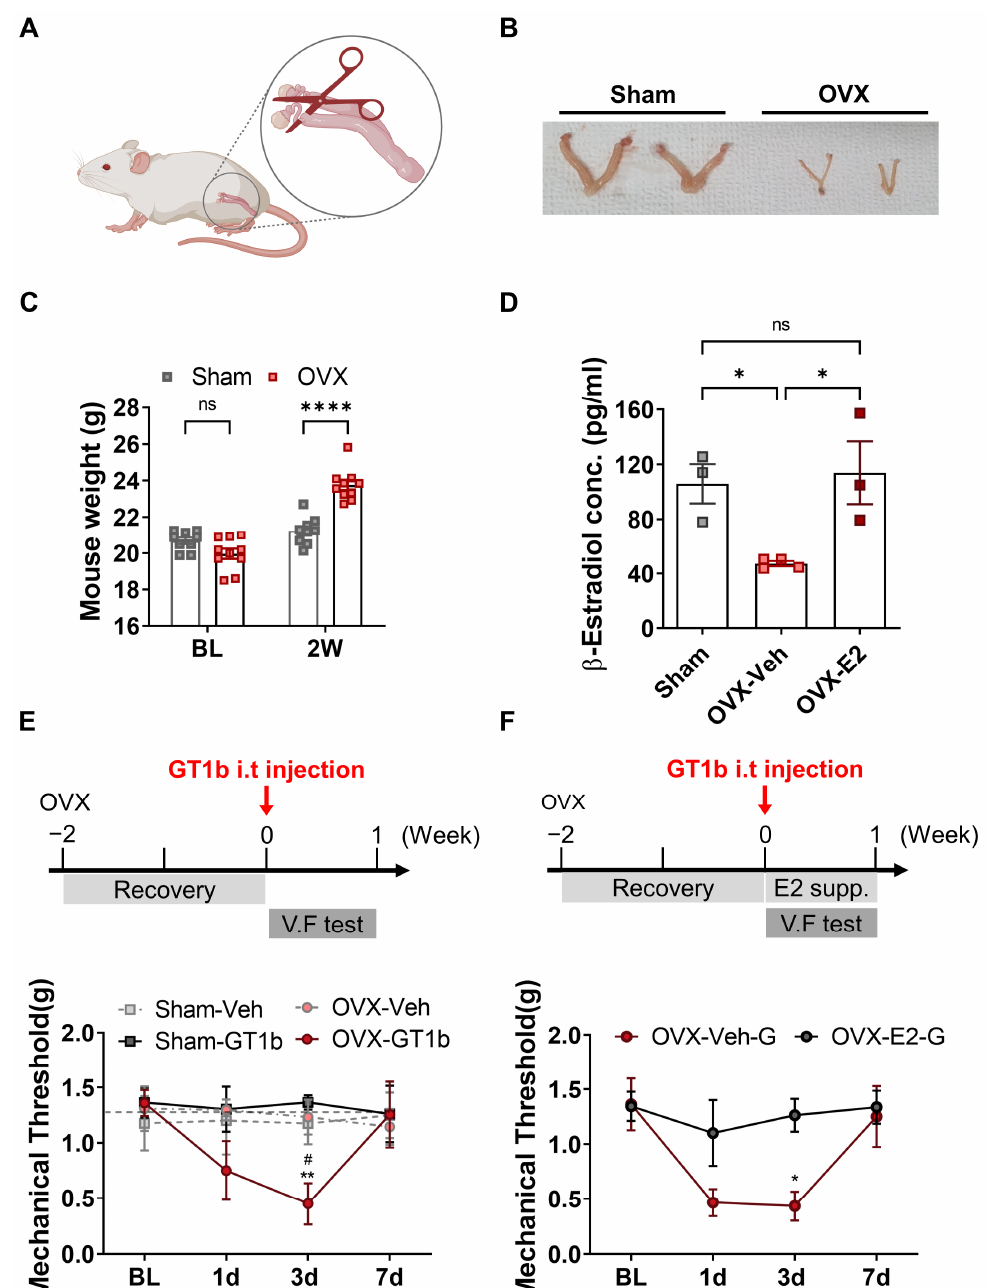
Figure 3. GT1b-induced mechanical allodynia relapse after OVX in female mice, which was reversed by estrogen supplement. ( A ) Schematic diagram of bilateral ovariectomy. ( B ) Representative images of uteri in sham and OVX mice 2 weeks after surgery. ( C ) Mouse weight (n = from 9 to 10/group, two-way ANOVA with post hoc Bonferroni’s multiple comparison test), and ( D ) serum levels of estradiol were measured 2 weeks after OVX (n = from 3 to 4/group, one-way ANOVA with post hoc Tukey’s multiple comparison test). ( E ) Mechanical allodynia was measured after GT1b i.t injection in animals with OVX (n = from 4 to 5/group, two-way ANOVA with post hoc Tukey’s multiple comparison test, # vs. Sham-GT1b, * vs. OVX-Veh), and ( F ) OVX — E2 supplementation (n = from 3 to 5/group, two-way ANOVA with post hoc Bonferroni’s multiple comparison test, # vs. OVX-Veh-V, * vs. OVX-E2-G). Data are presented as mean ± SEM. ns: not significant, * P < 0.05, ** P < 0.01, and **** P < 0.0001. OVX: ovaryectomy. Sham: control for ovarectomy. OVX-Veh-G: GT1b administered vehicle control group of ovaryectomized female. OVX-E2_G: GT1b administered E2 supplement group of ovaryectomized female. BL: basal level. 2W: 2